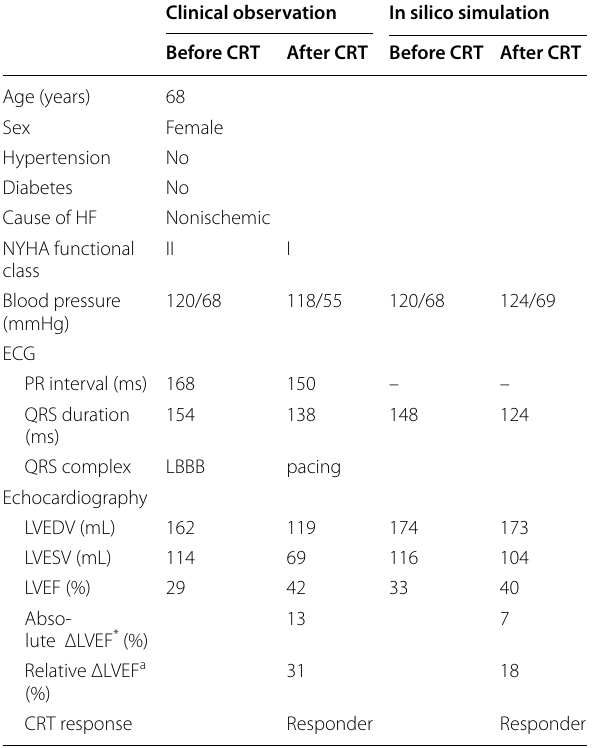
Table 1 Baseline characteristics, ECG, and echocardiographic data of the patient